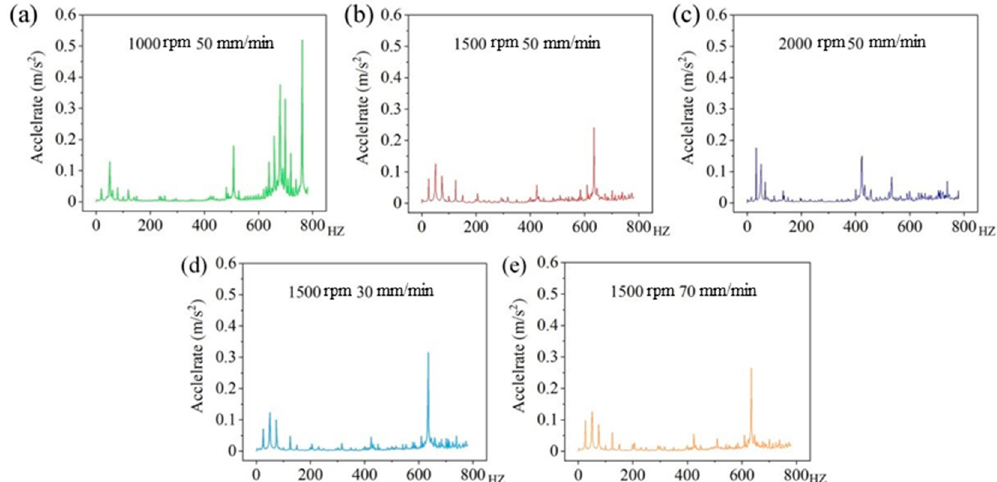
Figure 8. Vibration acceleration frequency spectra in the direction of Z. ( a ) 1000 rpm, 50 mm/min; ( b ) 1500 rpm, 50 mm/min; ( c ) 2000 rpm, 50 mm/min; ( d ) 1500 rpm, 30 mm/min; ( e ) 1500 rpm, 70 mm/min.